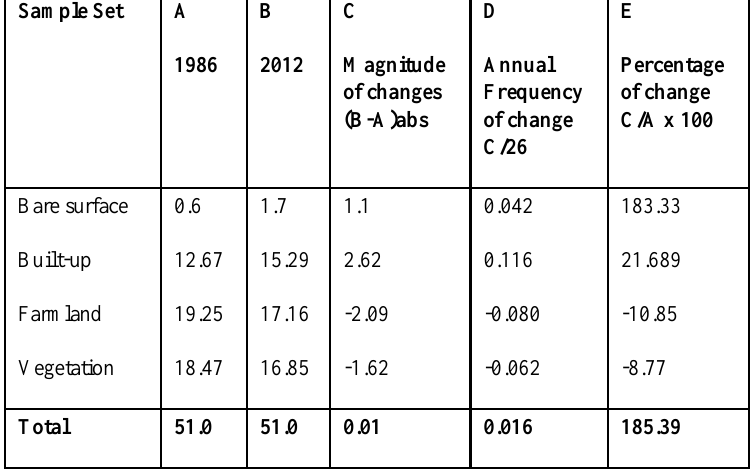
Table 6- Magnitude and percentage of change in Landcover between 1986 and